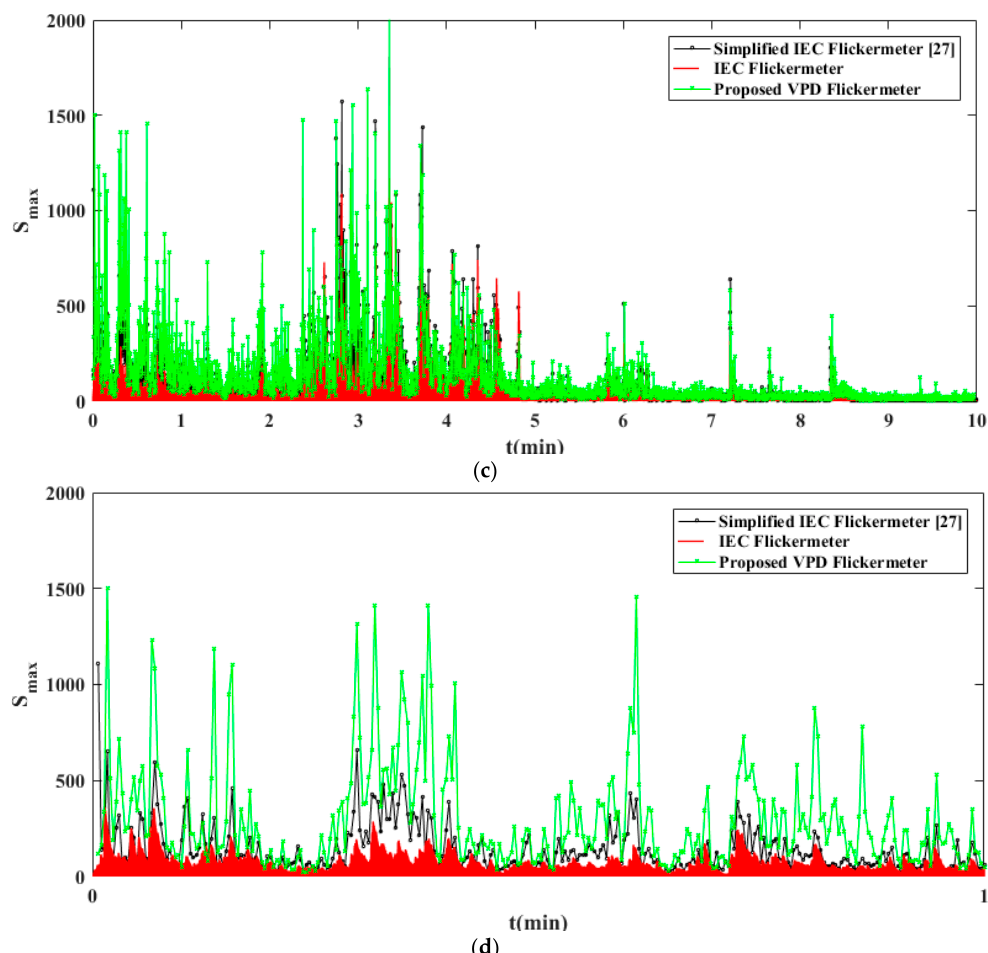
Figure 4. Evaluations for phase 2 ( a ) RMS variation; ( b ) fundamental frequency variation; ( c ) comparison of 10 min S max for different methods; ( d ) comparison of 1 min zoomed version of S max for different methods.